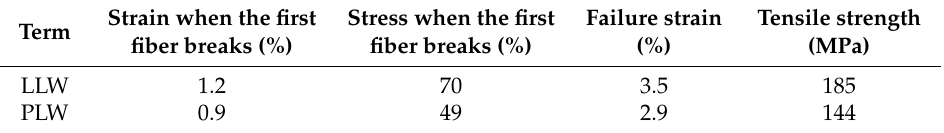
Table 6. Predicted mechanical properties of composites using two Weibull models.